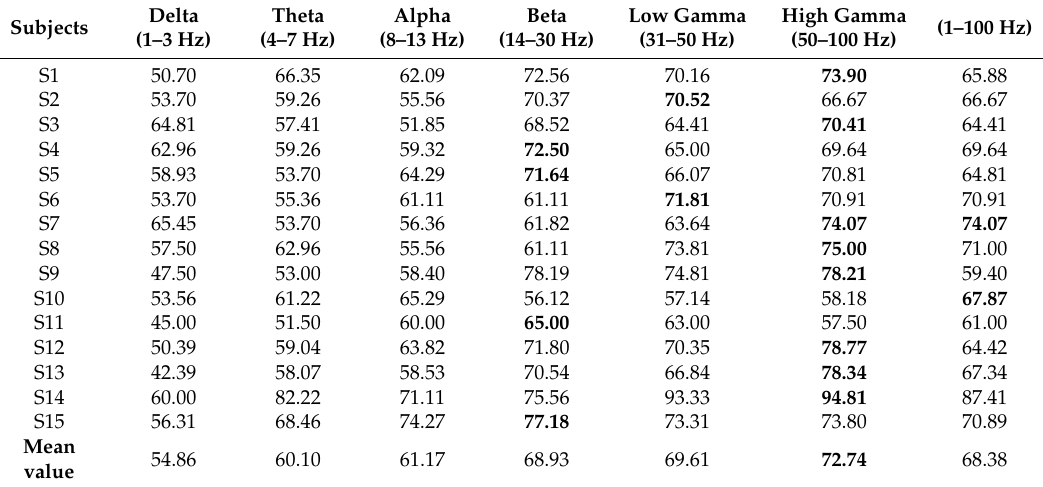
Table 2. Classification accuracies for each subject using common spatial patterns (CSP) for all considered frequency